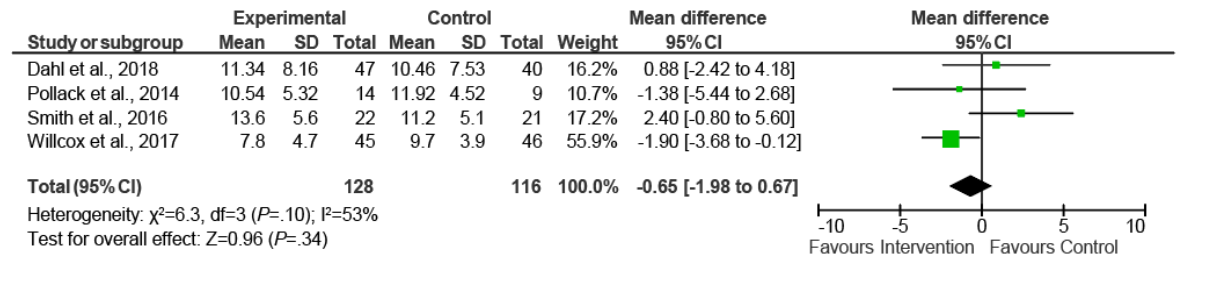
Figure 3. Pooled analysis of digital interventions on total gestational weight gain (kg)—per-protocol